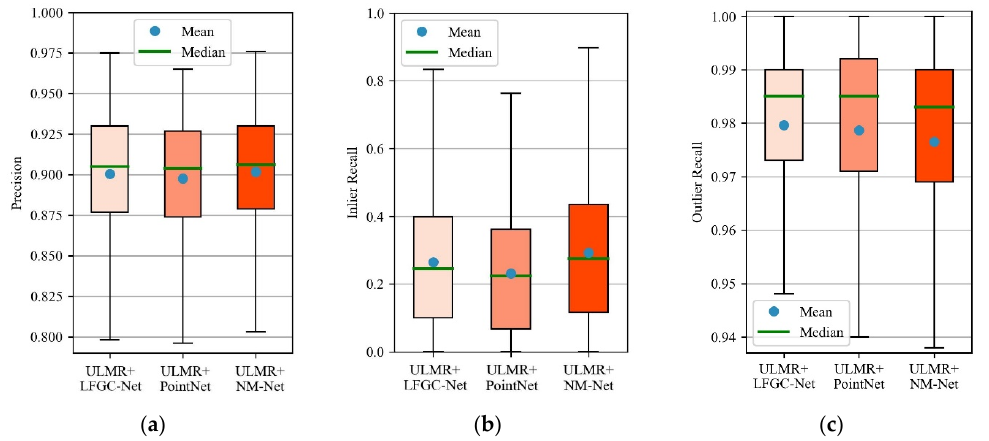
Figure 9. Boxplots of precision, inlier recall, and outlier recall for the three integrated methods. ( a ) Precision; ( b ) inlier recall; ( c ) outlier recall.